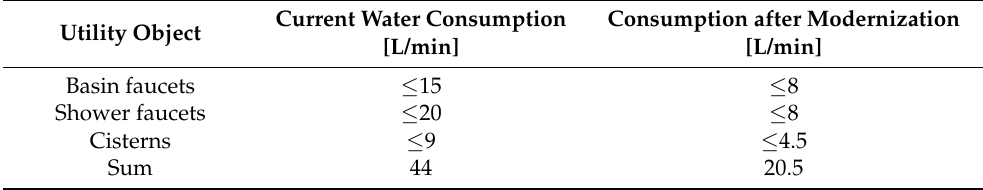
Table 4. Comparison of water consumption before and after modernization.